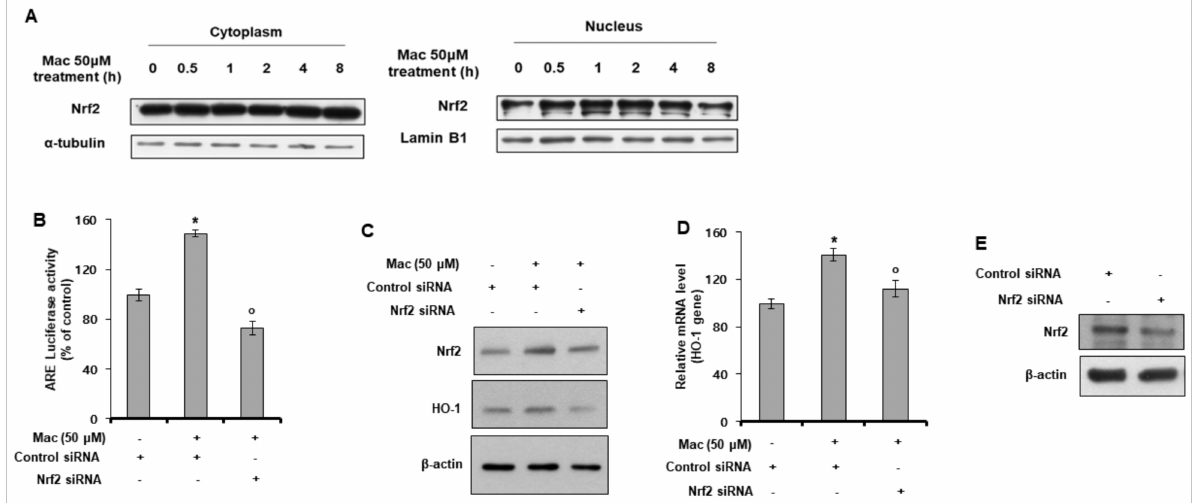
Figure 4. Maclurin induced nuclear translocation of Nrf2 and activated Nrf2-dependent ARE signaling. ( A ) HaCaT cells were treated with maclurin for 24 h and analyzed by Western blots of the cytosolic and nuclear fractions to assess Nrf2 translocation. ( B ) HaCaT cells were transfected with the ARE-Luc reporter and a Renilla-luciferase vector and siRNA for the Nrf2 gene using the DharmaFECT ® Duo transfection reagent. After 24 hincubation, the cells were treated with maclurin for 14 h. The cells were lysed and analyzed by the luciferase reporter assay. The data are presented as the mean ± SD of three replicates. * p < 0.05 vs. untreated control, o p < 0.05 vs. maclurin-treated control. ( C – E ) HaCaT cells were transfected with Nrf2 siRNA using the DharmaFECT ® Duo transfection reagent. After incubation for 24 h, the cells were treated with maclurin for 14 h. The cells were lysed and analyzed by Western blots ( C , E ) and RT-PCR ( D ). The data are presented as the mean ± SD of three replicates. * p < 0.05 vs. untreated control, o p < 0.05 vs. maclurin-treated control. Mac: maclurin.